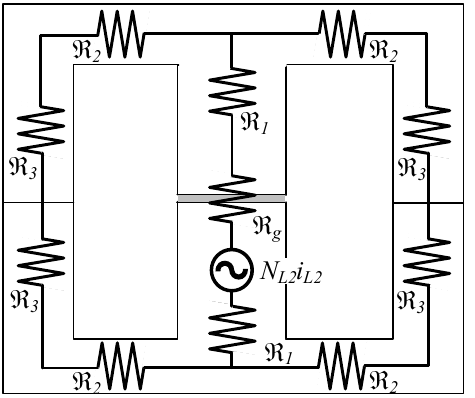
Figure 7. Reluctance model of VI.